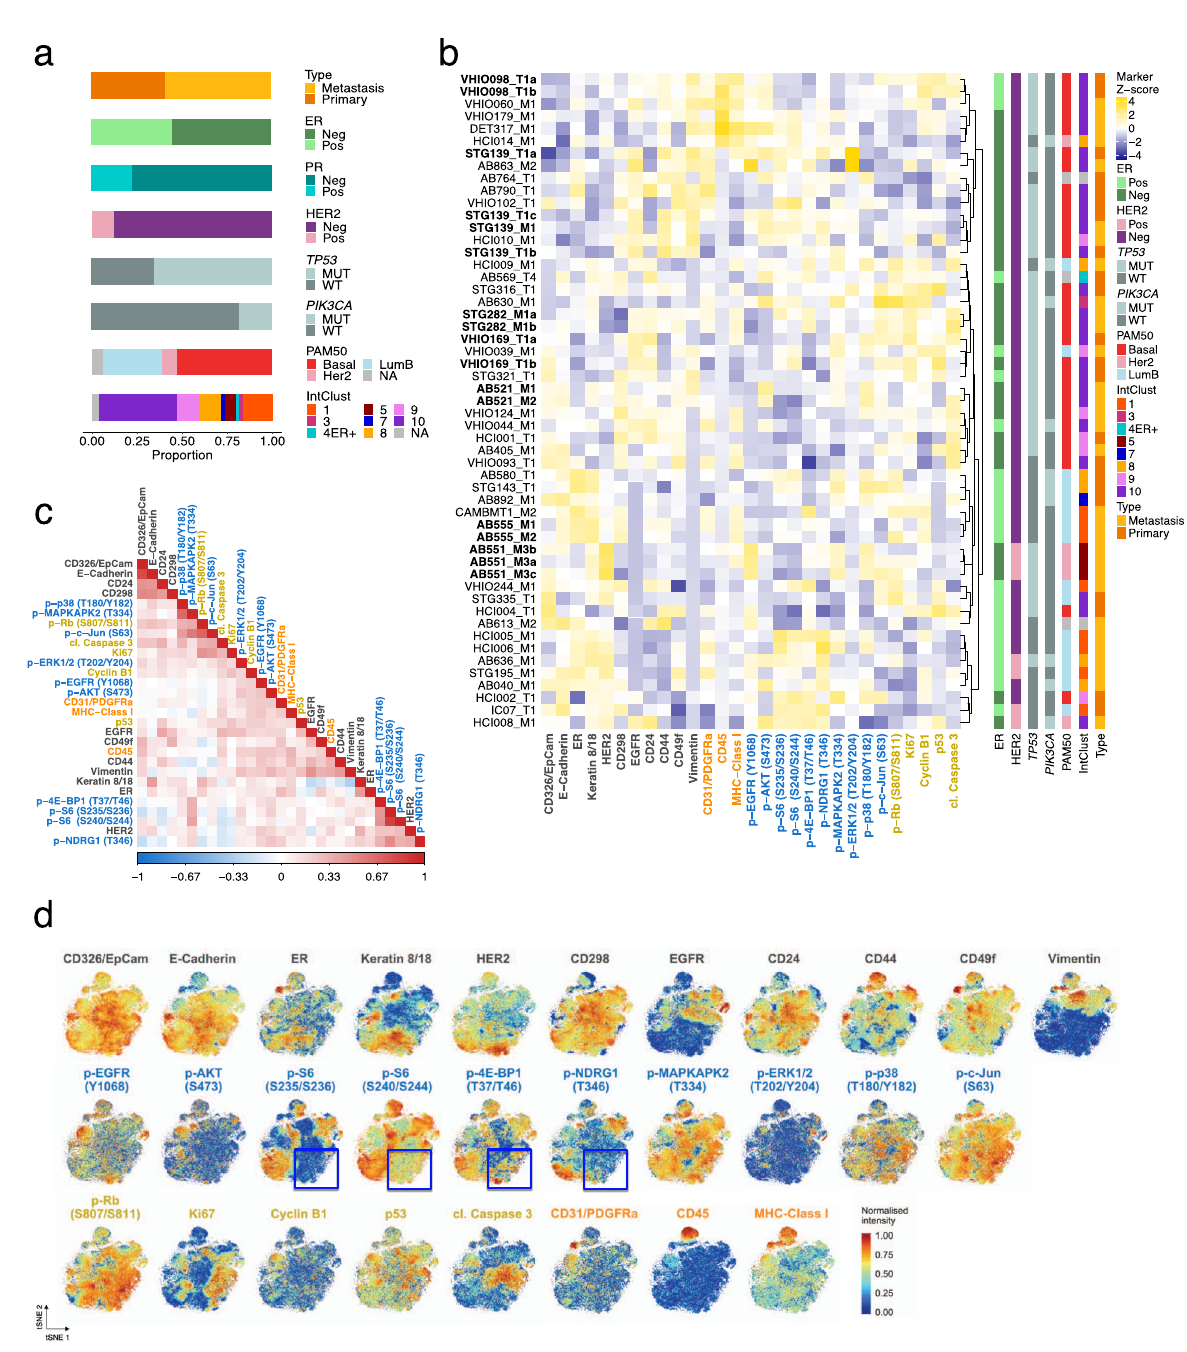
Fig. 2 Characterisation of protein expression in breast cancer PDTXs using the BCMC panel. a Histological and molecular features of the 53 PDTX models pro fi led by mass cytometry. Neg: IHC determined Negative, Pos: IHC determined positive, MUT: mutation present, WT: wild-type. b Heatmap of median expression of all proteins tested by BCMC panel across 53 PDTXs with their associated histological and molecular features on the right panels. PDTXs used as experimental set reference samples or originating from the same patient are represented in bold. The marker subpanel is colour coded as in Fig. 1a. c Heatmap of the pairwise Spearman ’ s correlation coef fi cient values of all markers across all PDTX cells ( N cells = 405,827). The marker subpanel is colour coded as in Fig. 1a. d tSNE plots showing single-cell level expression of all BCMC markers across 49 PDTXs ( N cells = 78,400). tSNE areas, where mutual exclusivity of 4 mTOR pathway effectors is present, are indicated by blue boxes. The marker subpanel is colour coded as in Fig.